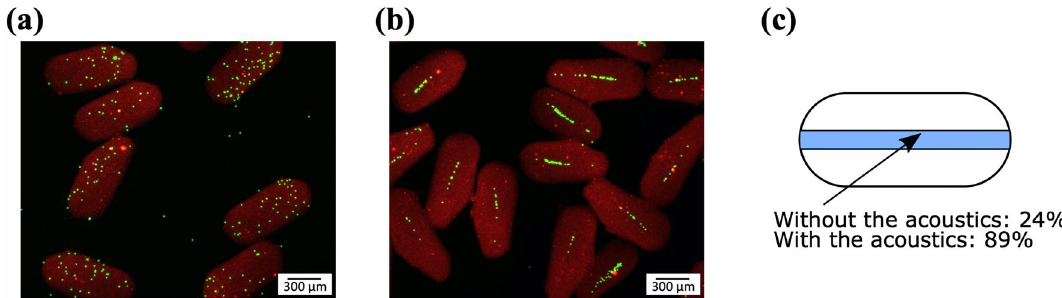
Figure 3. Hydrogel droplets with encapsulated beads after cross-linking and washing (a) Without the acoustics applied the 10 µm green beads are randomly positioned in the droplets. (b) With the acoustics applied the 10 µm green beads are focused along the centre line of the droplets. (c) The amount of 10 µm green fluorescent beads in the region of interest (ROI, marked in blue in the image) without and with the acoustics applied.